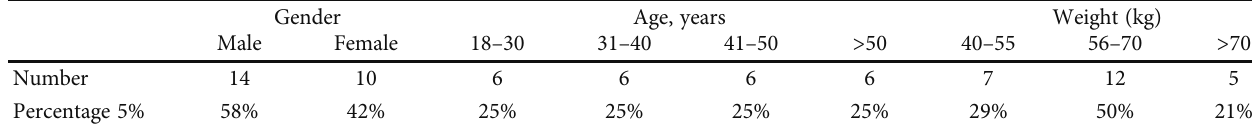
Table 2: Some information with respect to